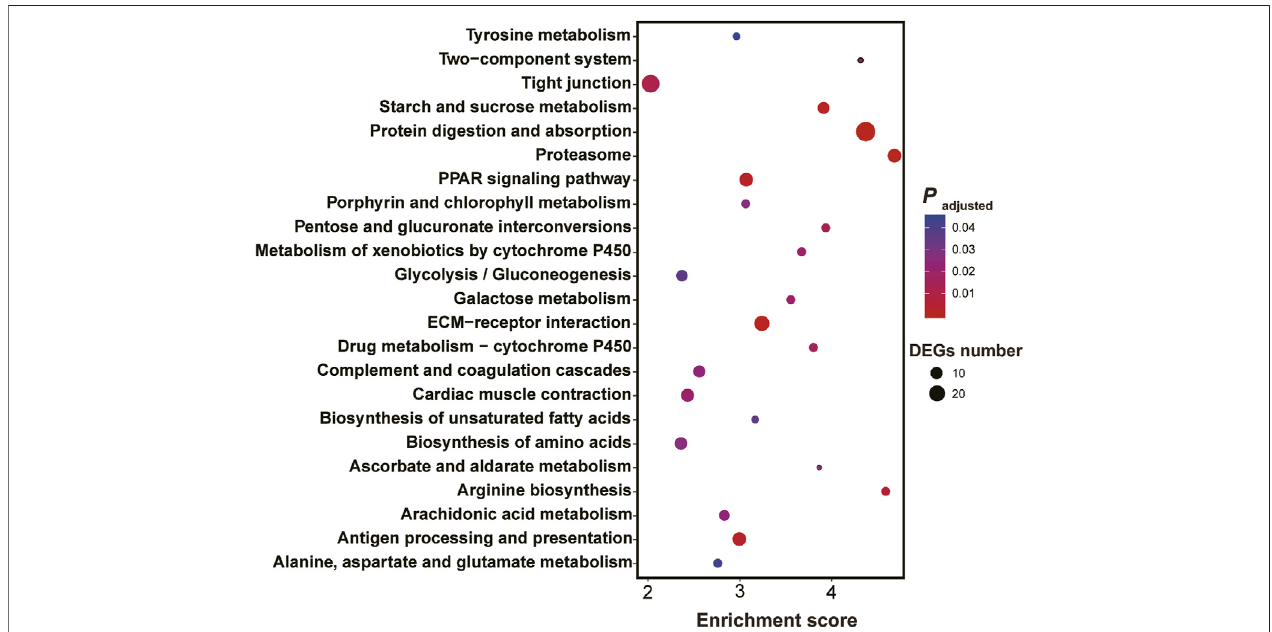
FIGURE 4 | Results of KEGG enrichment with differentially expressed genes in the larval Ietalurus punetaus after 48 h of exposure to 50 mg/L polystyrene nanoplastics.